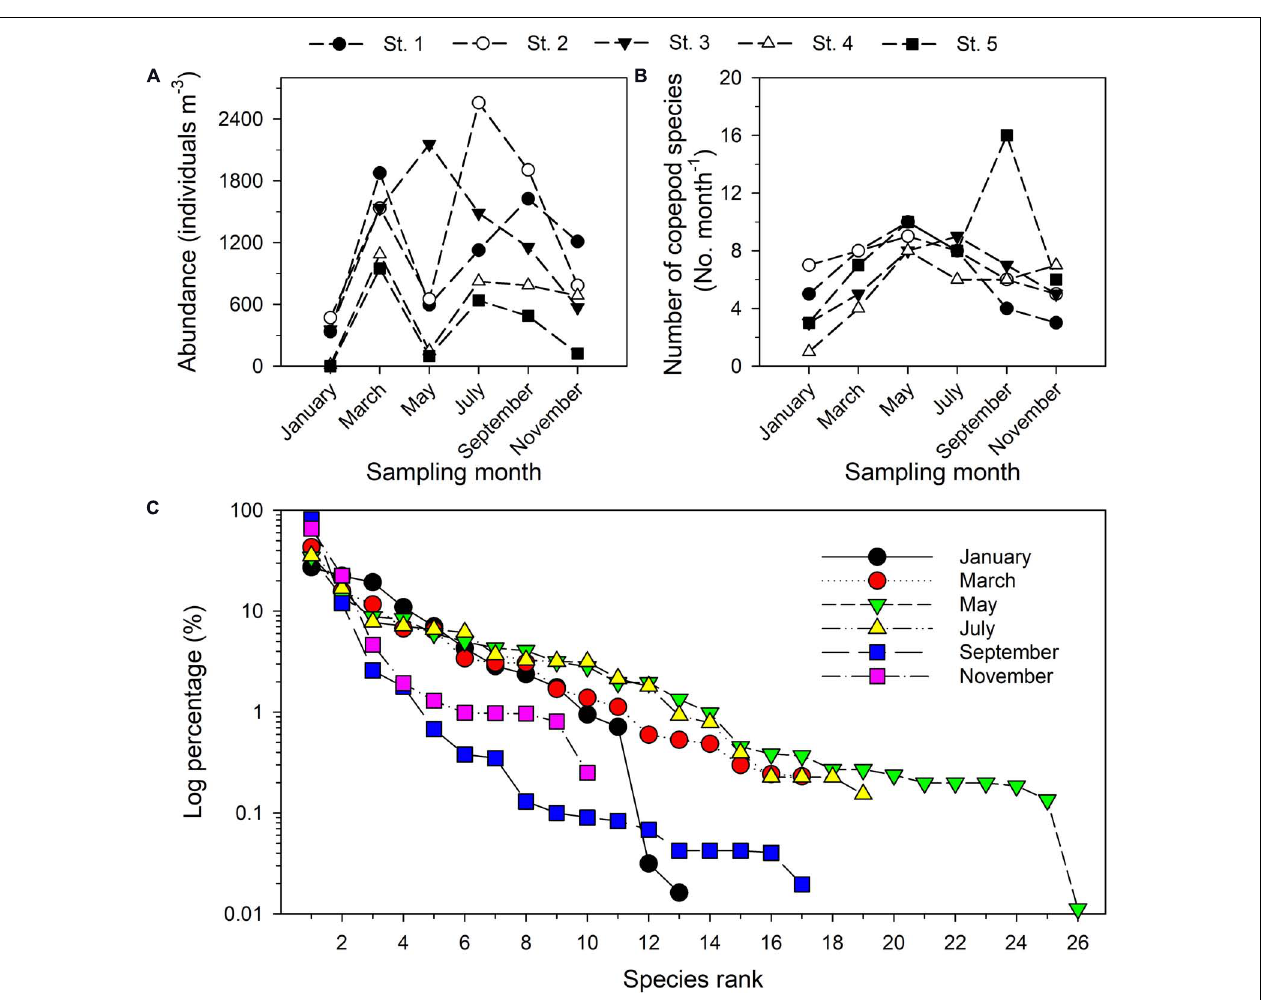
FIGURE 5 | Total copepod abundance (A) , number of distinguished copepod taxa (B) , and rank abundance diagrams of planktonic copepods sampled bimonthly in 2014 in the Danshuei River estuary (C) . The y -axis (percentage) is given as a log 10 scale.